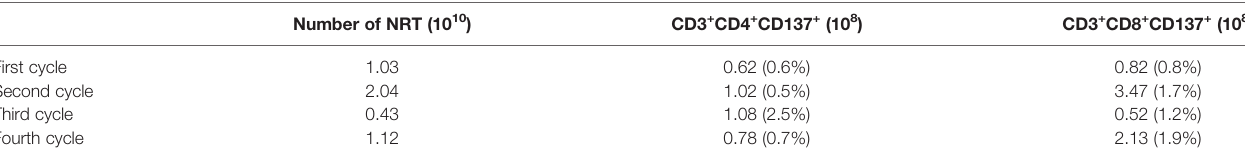
TABLE 1 | The amount of T cells reinfusion per cycle and the amount of NRT immune cells detected in-vivo